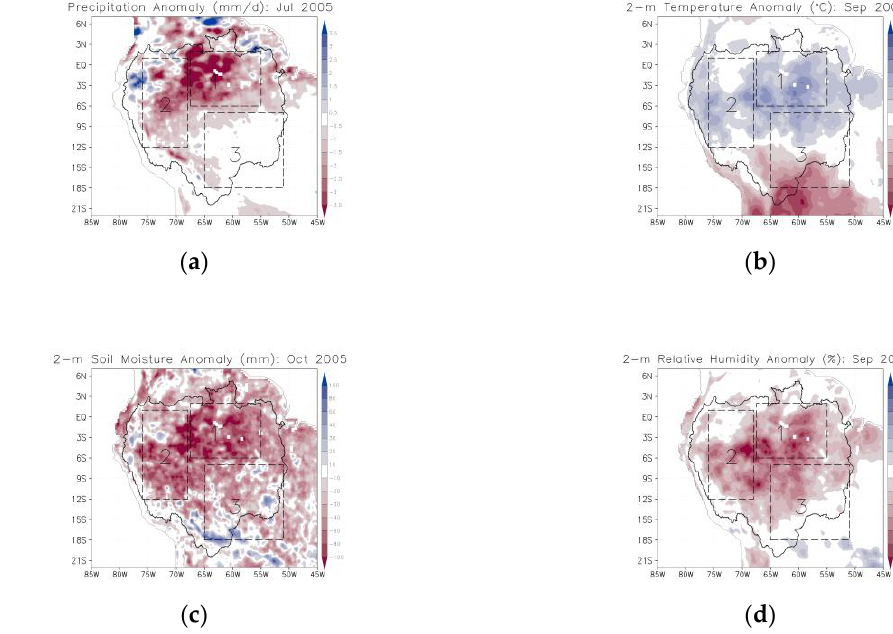
Figure 10. The 2005 drought anomaly fields of: ( a ) precipitation in July (mm/d); ( b ) temperature at 2-m above ground in September ( ◦ C); ( c ) 2-m integrated soil moisture in October (mm); ( d ) relative humidity at 2-m above ground in September (%). Boxes (dashed lines) delimit areas: north (1), west (2), and southeast (3). Solid black contour encompasses the Amazon basin.